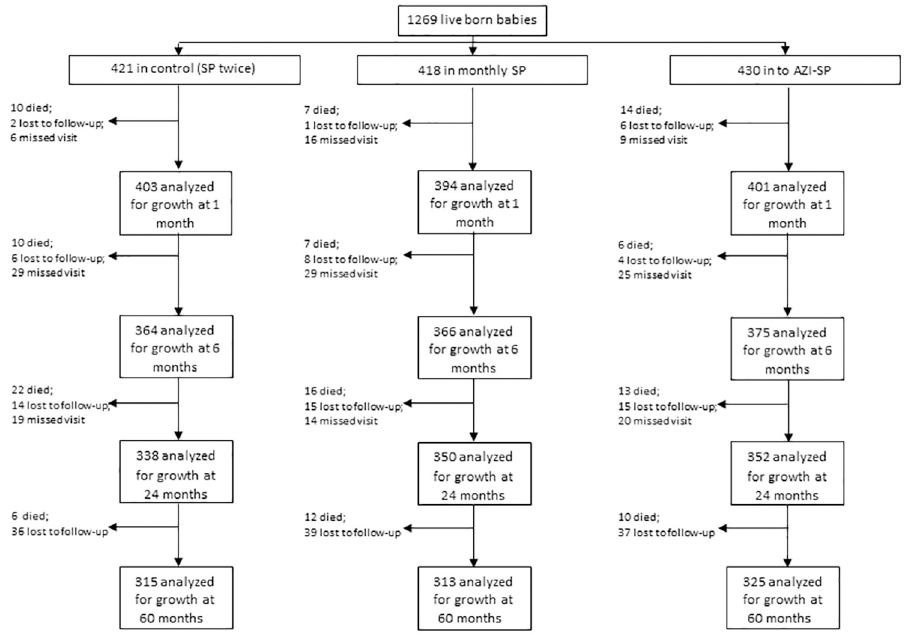
Fig 1. Follow-up of liveborn children. SP = sulfadoxine-pyrimethamine; AZI-SP = intervention group with monthly SP and two doses of azithromycin.